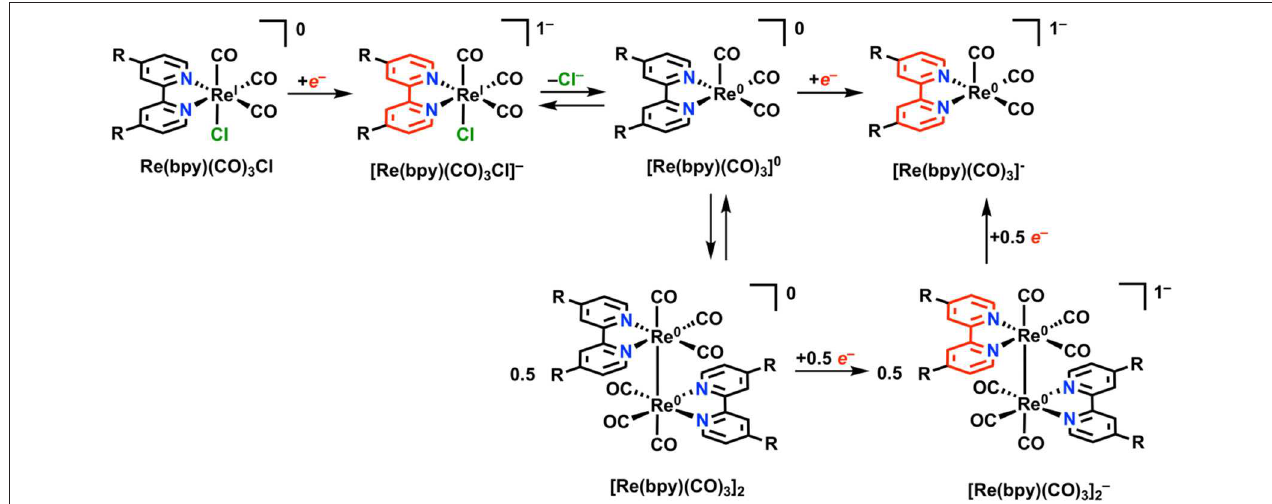
FIGURE 7 | Faradaic reduction of Re(bpy)(CO) 3 X. Adapted with permission from Machan et al. (2014b). Copyright 2014 American Chemical Society.